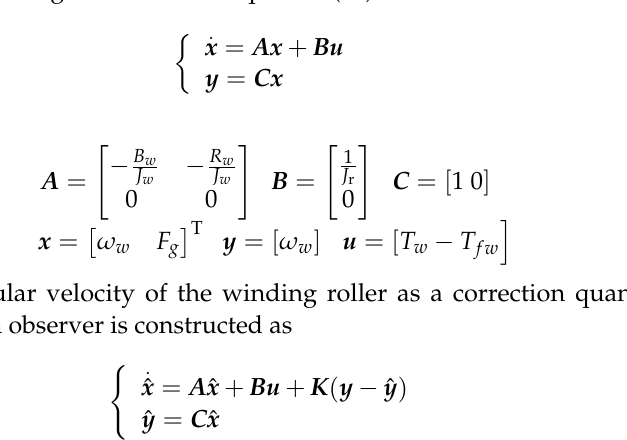
f f v = = Figure 4. Adaptive weighted fusion algorithm structure.